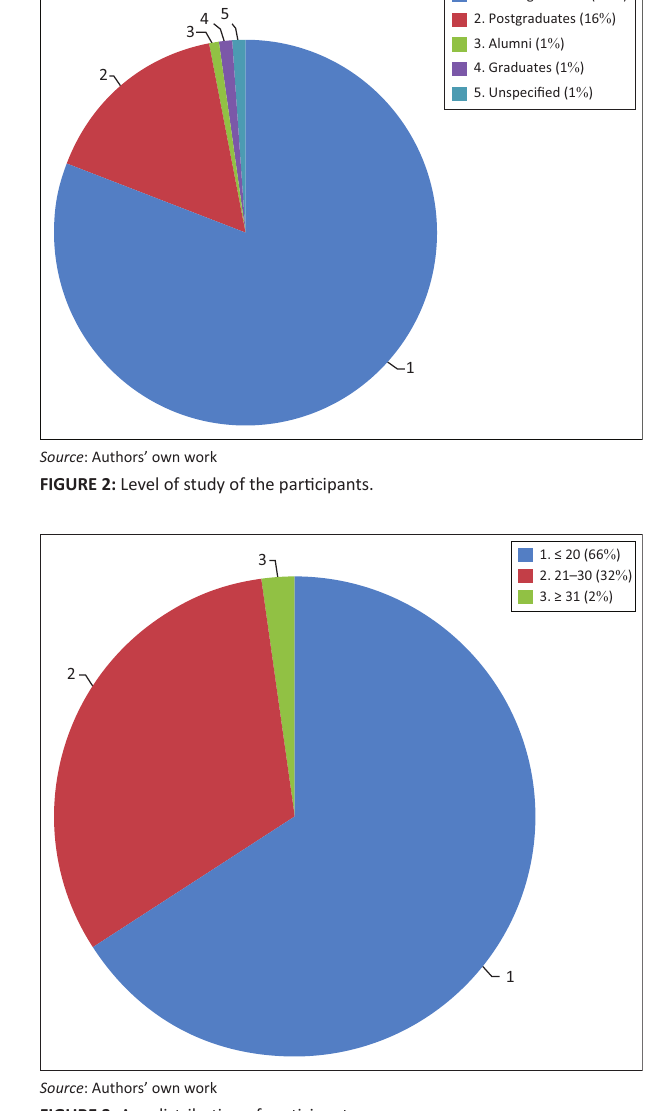
FIGURE 3: Age distribution of